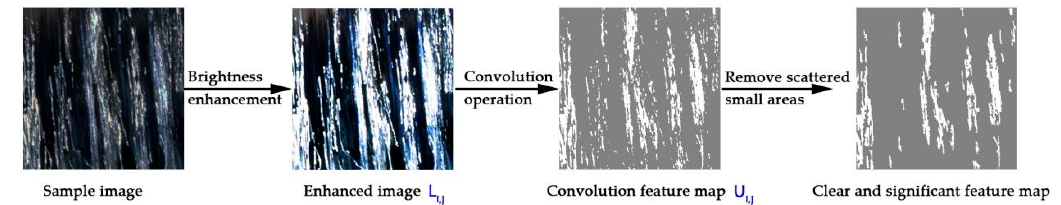
Figure 2. Operation process for image feature extraction.